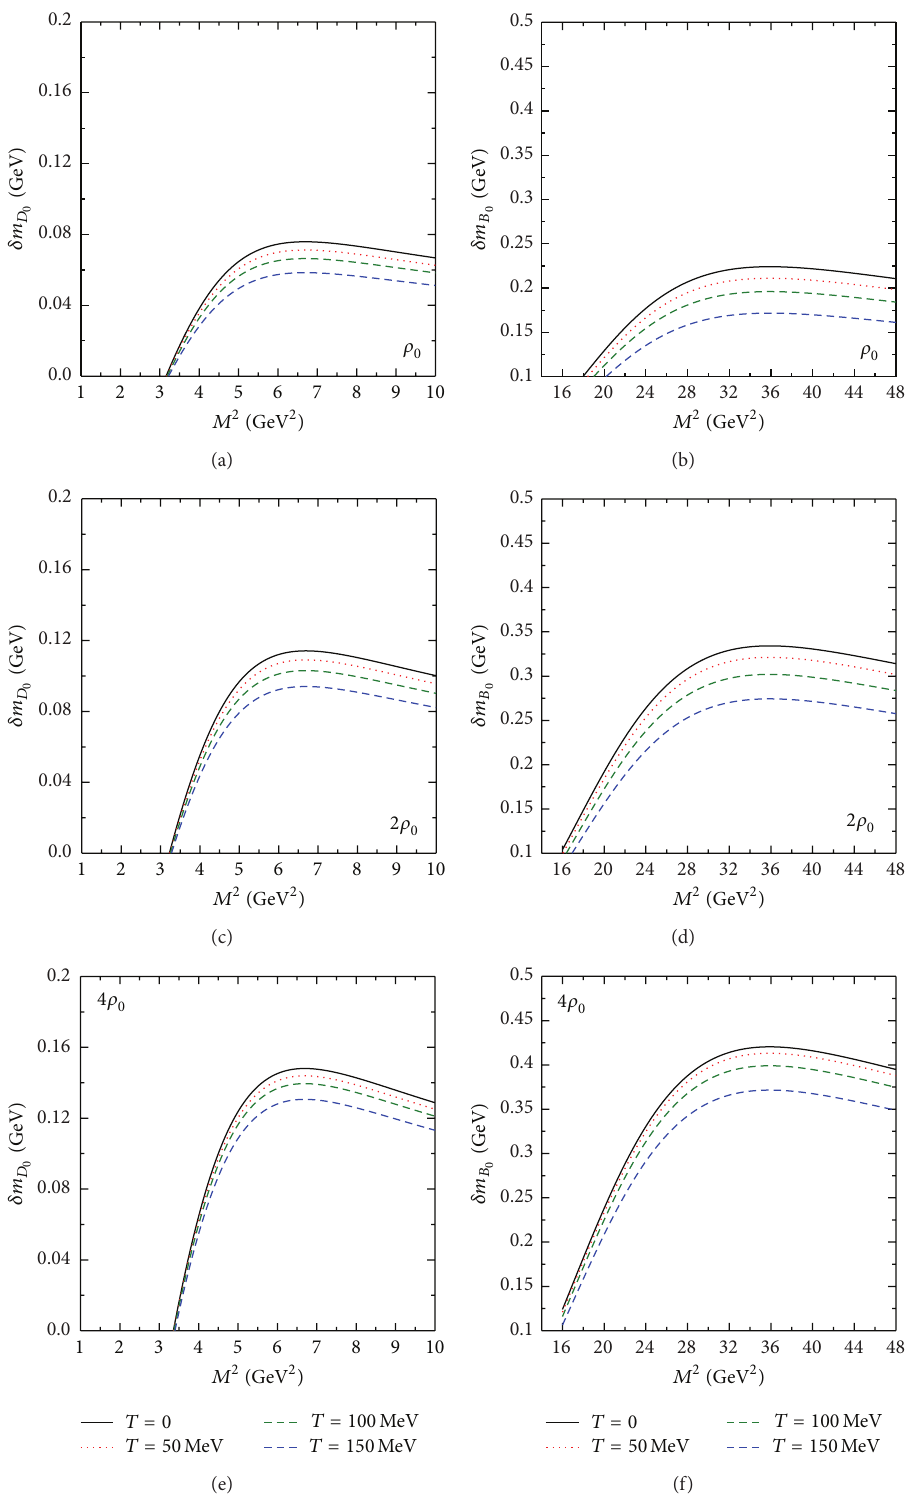
Figure 3: (Color online) Figure shows the variation of the mass shift of scalar mesons 𝐷 0 (subplots (a), (c), and (e)) and 𝐵 0 (subplots (b), (d), and (f)) as a function of the squared Borel mass parameter, 𝑀 2 . We show the results at baryon densities 𝜌 0 , 2𝜌 0 , and 4𝜌 0 . For each value of baryon density the results are shown at temperatures, 𝑇 = 0, 50, 100, and 150MeV. Also the medium modifications of decay constants and masses of pions and kaons are considered while evaluating the above shown mass-shift of scalar